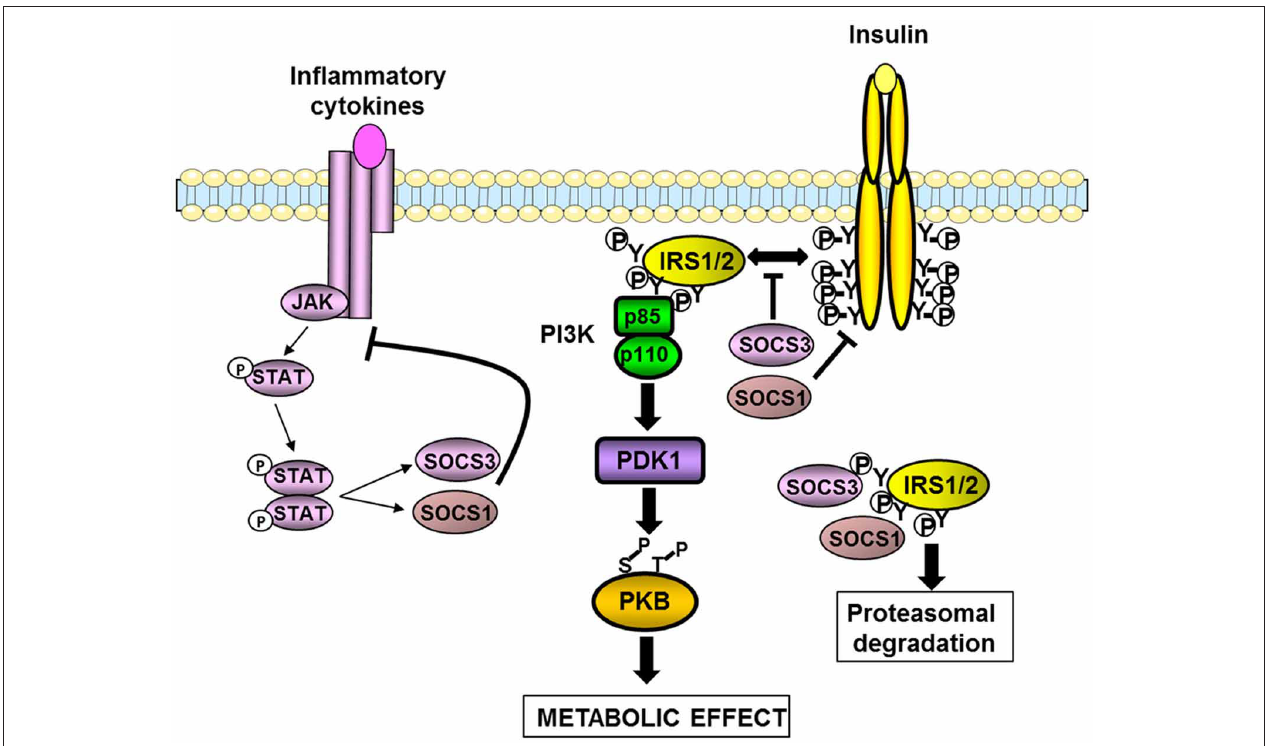
FIGURE 2 | Inhibition of insulin signaling pathway by SOCS1 and SOCS3. SOCS1 and SOCS3 are induced by cytokines and involved in a negative feed-back loop. SOCS1 and SOCS3 also inhibit insulin signaling by different mechanisms. They interfere with the binding between the insulin receptor and IRS1/2 proteins. SOCS1 also inhibits the tyrosine kinase activity